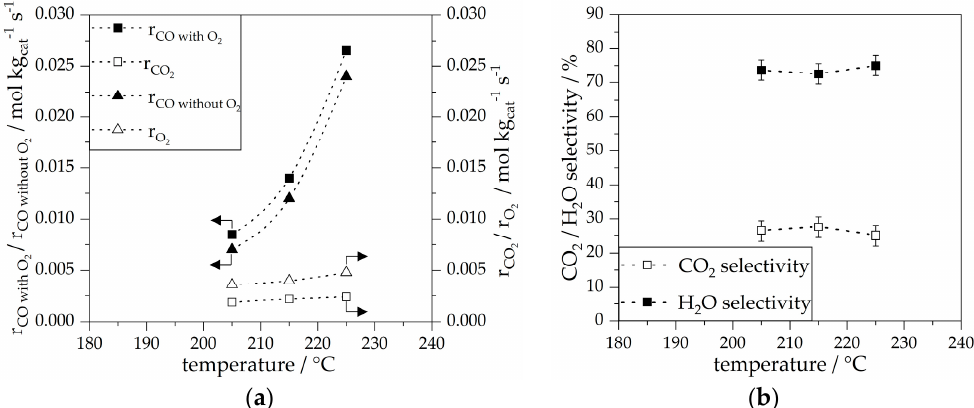
Figure 4. ( a ) Reaction rates of CO, CO 2, and O 2 during FTS with O 2 -free and O 2 -containing syngas. ( b ) H 2 O and CO 2 selectivity of occurring O 2 consumption. Conditions: T = 205–225 °C; p = 20 bar; 𝑉(cid:4662) . total = 11.5–18 L/h (NTP); p CO = 5 bar; p H2 = 10 bar, p N2+O2 = 5 bar; m cat (Co/Pt/Al 2 O 3 ) = 1 g; X CO = 0.01–0.02 (only by FTS); X O 2 = 0.2.